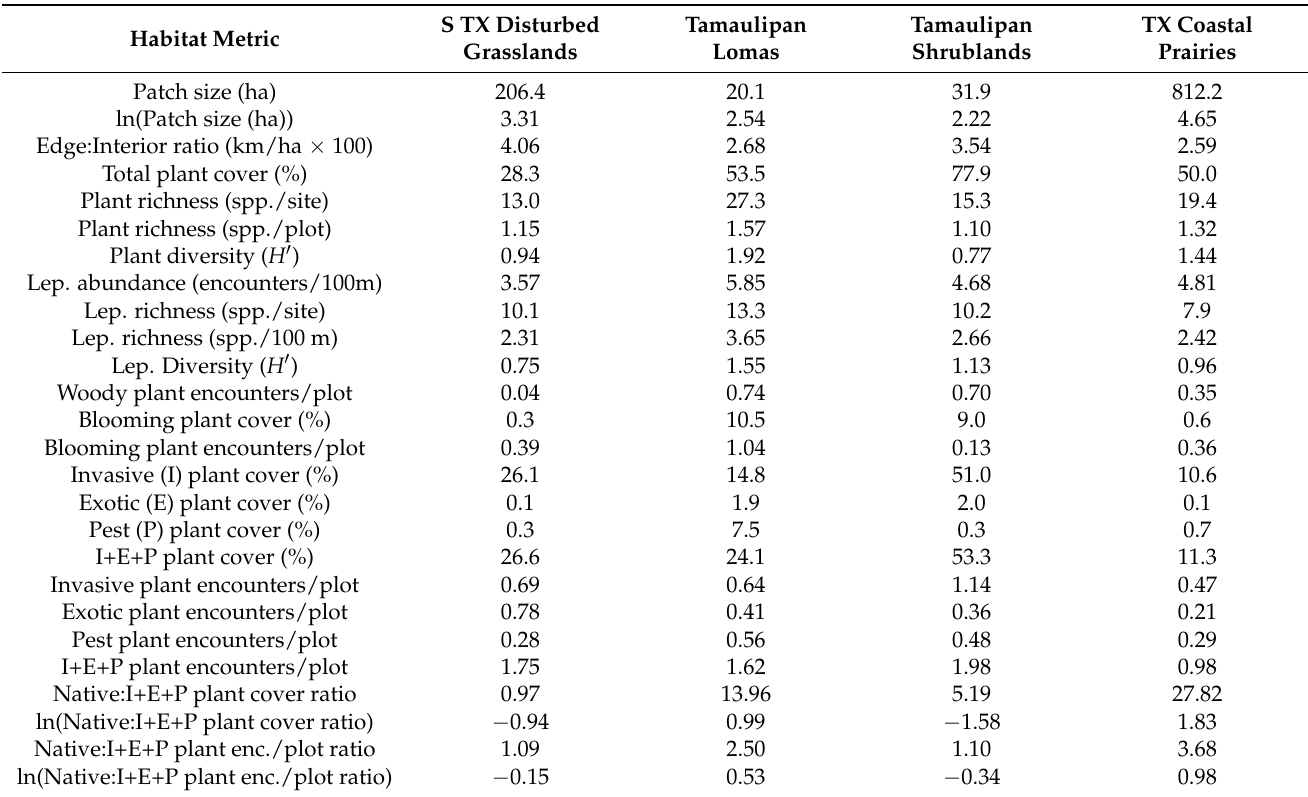
Table 3. Average values of 26 habitat metrics for the four focal habitat classes surveyed. Bloom abundance was not quantified for individual plots or sites, but species in bloom during surveys were recorded; thus, bloom metrics represent the prevalence of species known to have been in bloom at the time, not necessarily the abundance or cover of blooms